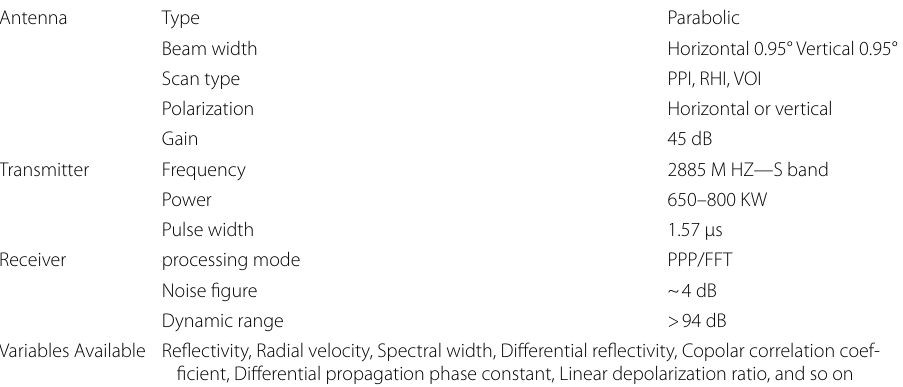
Table 1 The characteristics of CINRAD-SA radar Antenna